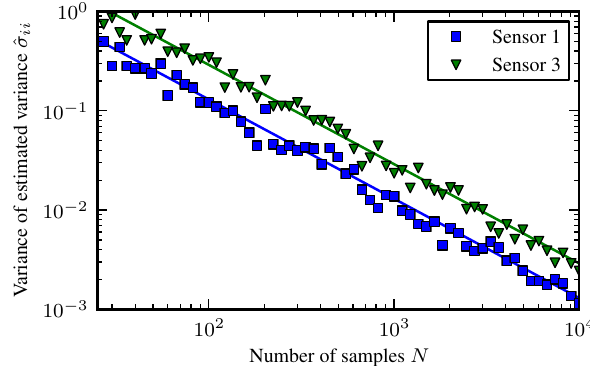
Fig. 3. Convergence of the variance of the estimated variance as the number of samples N grows. The markers indicate the sample variance obtained by running 50 simulations for each N . The solid lines are the theoretical values given by Eq. (14).